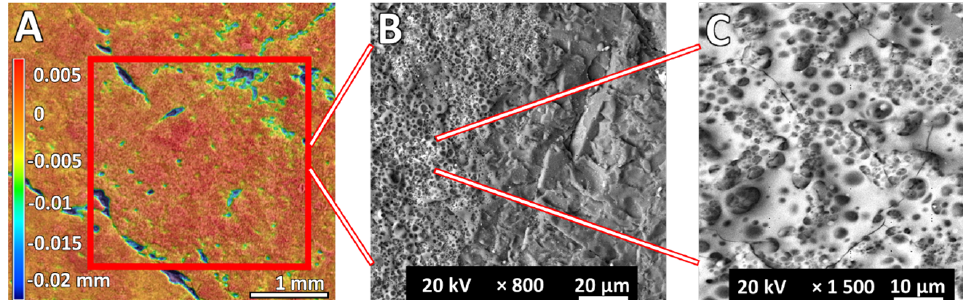
Figure 10. Ablation site for the Bivoj laser on the chondritic meteorite Dho 1709, created under a flow of water without any evidence of altitude differences ( panel A ). Detailed image of the spot rim, showing the clear boarder of the irradiated area ( panel B ). Detailed structure of the sample surface inside the laser spot, indicating the significant melting of the meteorite ( panel C